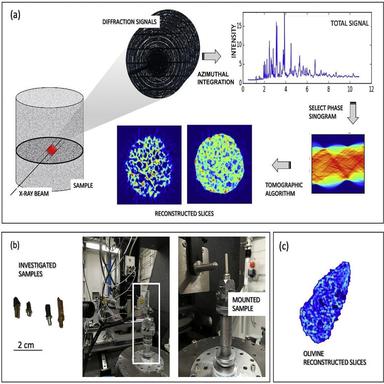
X-ray diffraction Computed Tomography (XRDCT): (a) reconstruction scheme of the XRDCT analysis; (b) samples investigated in the present study (meteorite, Pietra di Angera, and ancient ceramic) and inset of the experimental setupat ID15B ESRF; (c) example of a reconstructed slice of a (hkl) peak mineral phase.